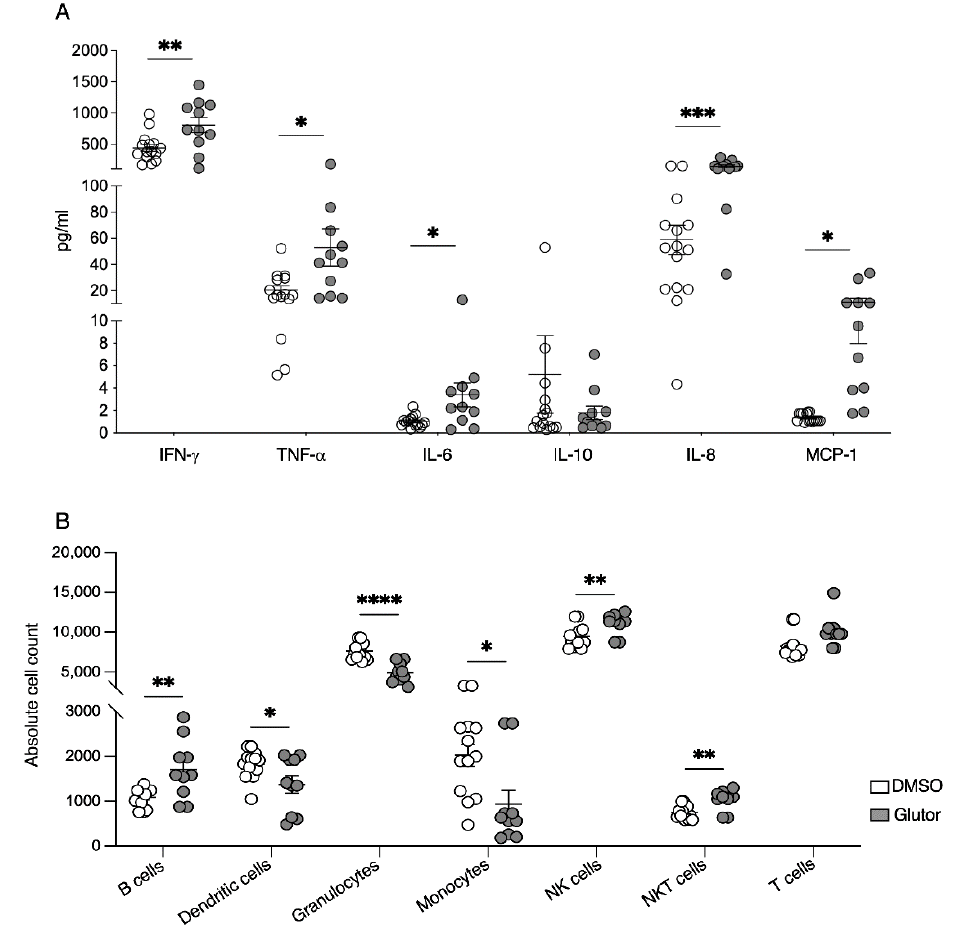
Figure 5. Long-term treatment with Glutor leads to alterations in the chemokine profile. ( A ) Su- pernatants of long-term treated NK cells (white: 0.1% DMSO; grey: 100 nM Glutor) were collected 24 h after splitting of cells and used for analysis of spontaneous secretion of different cytokines and chemokines using a cytometric bead-based array: n = 11–15. Data were pooled from eleven independent experiments and each experiment was performed with one or two donors. Mean with SEM. Statistics: paired t -test. ( B ) Absolute cell count of B cells, dendritic cells, granulocytes, mono- cytes, NK cells, NKT cells and T cells after performing a migration assay. Supernatants of long-term treated NK cells were (white: 0.1% DMSO; grey: 100 nM Glutor) used for the lower chamber and 0.25 × 10 6 PBMCs + Granulocytes were added in the Transwell. After 5 h incubation, migrated cells were analyzed using flow cytometry: n = 10–13. Data were pooled from four independent experiments and each experiment was performed with 2–4 donors. Statistics: paired t -test. Significant differences are indicated by asterisk: * p ≤ 0.05, ** p ≤ 0.01, *** p ≤ 0.001, **** p ≤